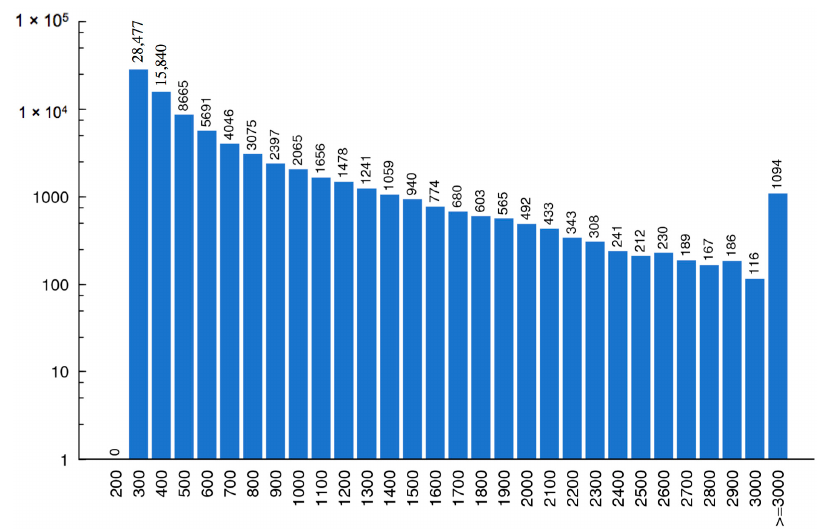
Figure 3. Length distribution of unigenes. The horizontal coordinate represents unigene length and the vertical coordinate stands for number of unigenes.